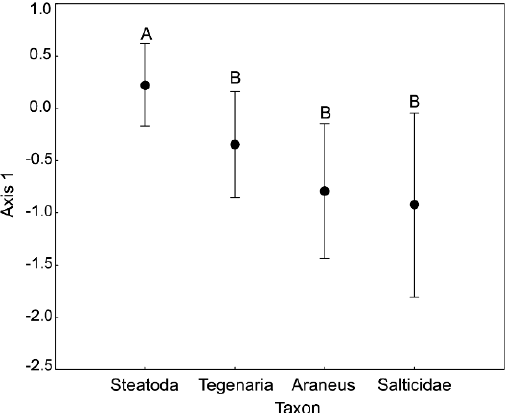
Figure 3. Multivariate analysis of stoichiometric relations in the four taxa of spiders (PCA). ANOVA performed for the 1st axis scores. Different letters denote significant differences in multielemental stoichiometry between taxa (F = 18.70, p = 0.02). Bars denote the confidence intervals. Table 1 provides information on the contribution of different elements to the scores of Axis 1.